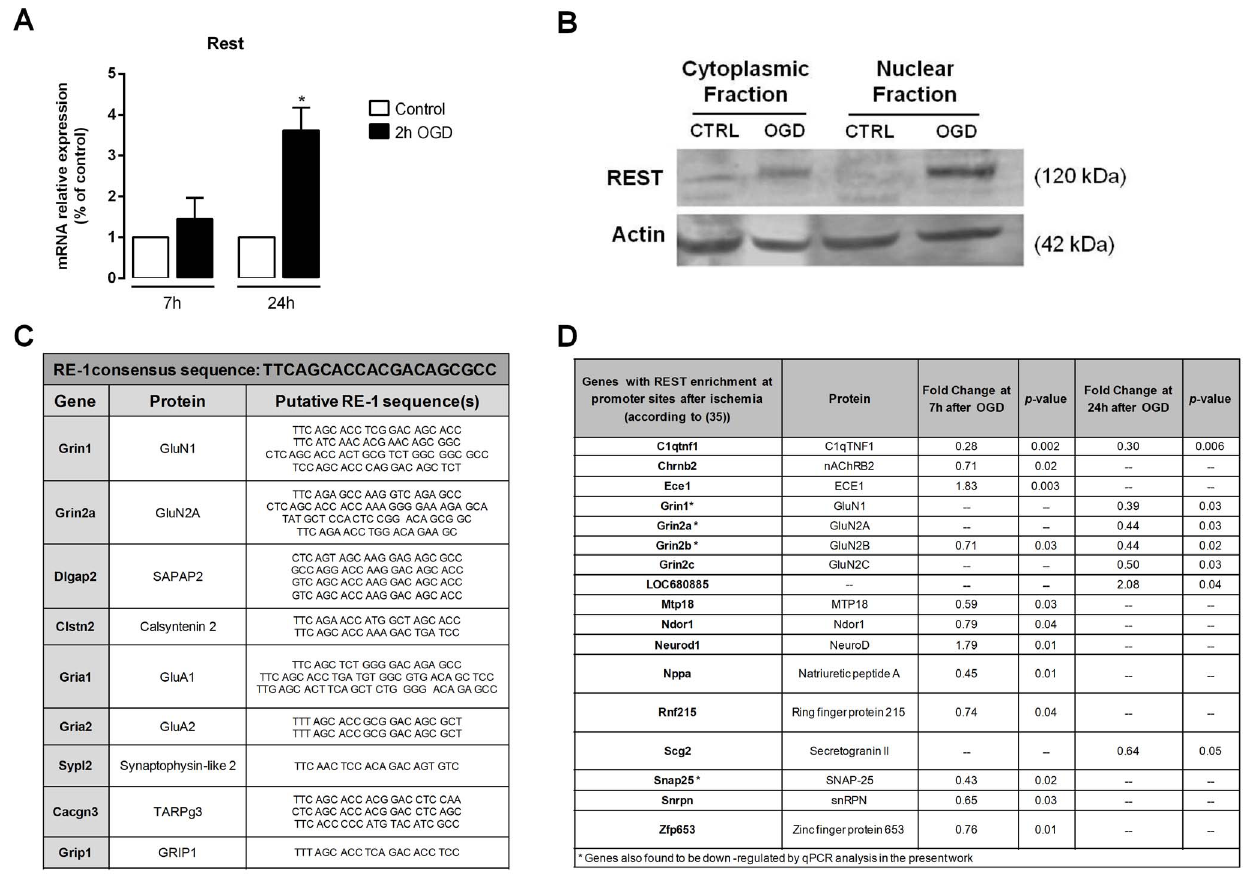
Figure 7. OGD increases REST expression in mature hippocampal neurons. ( A ) Quantitative PCR analysis showed the OGD insult induced a marked increase in Nrse (Rest) mRNA. Total RNA was extracted with TriZol 7 h and 24 h after the OGD insult. Quantitative PCR analysis was performed using cDNA prepared from 1 m g of total RNA and specific primers for each selected gene. Fold change in mRNA levels was normalized to Gapdh and Actb. Bars represent the mean 6 SEM of three independent experiments, performed in distinct preparations. *Significantly different from control (* p , 0.05, Student’s t -test on log-transformed data). ( B ) Representative Western blot shows a marked increase in REST protein levels, both in the cytoplasmic and nuclear fractions of hippocampal neurons submitted to OGD followed by 24 h of incubation in culture conditioned medium (n=3). Actin was used as loading control. ( C ) Putative RE-1 sequence(s)/REST-binding site(s) in synaptic genes (according to [35]) found to be down- regulated after OGD. (D) Genes with enrichment of REST after ischemia (according to [33]) found to be differently expressed after